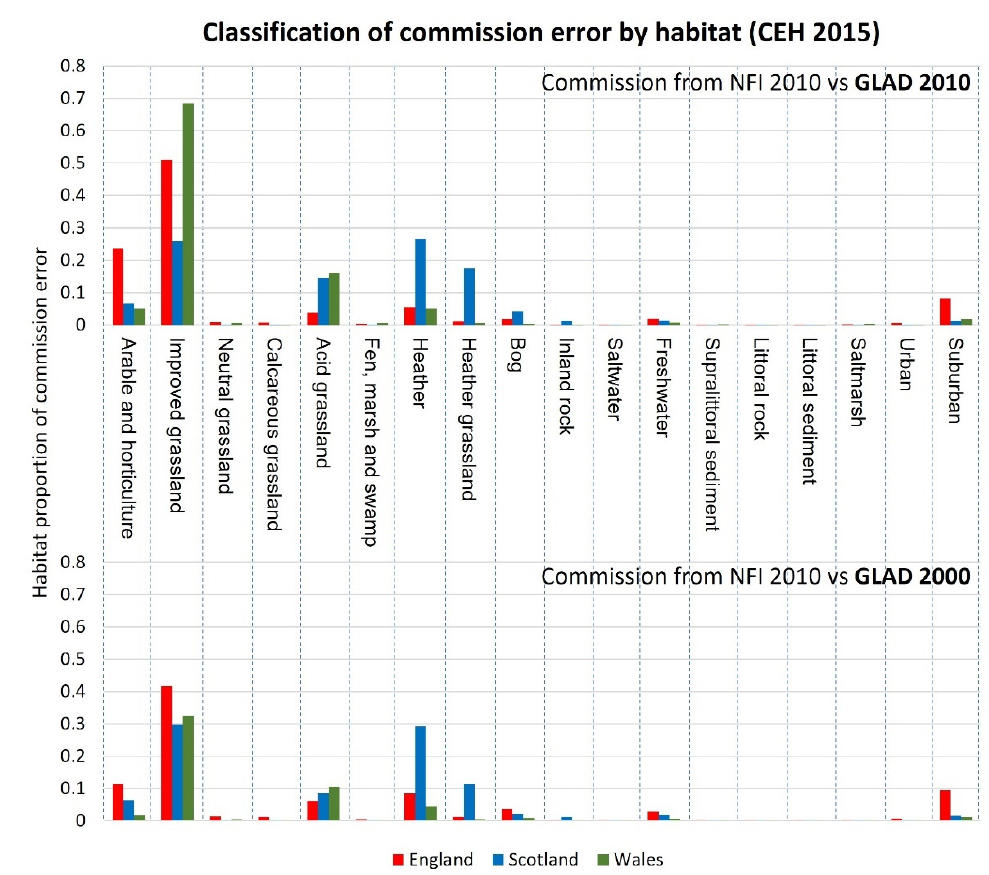
Figure 4. Classification of commission error by habitat for 2010 NFI vs. 2010 GLAD FC and 2010 NFI vs. 2000 FC.